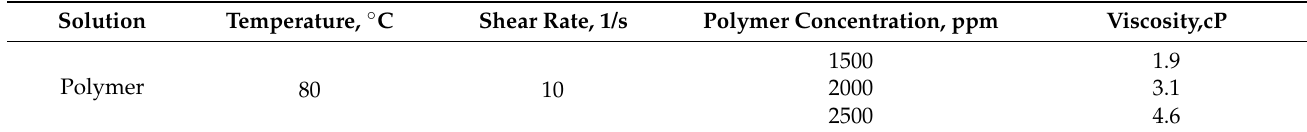
Figure 6. Rheology of polymers (1500, 2000, 2500 ppm) and nano-assisted polymer at 80 °C. Table 10. Rheology of pure polymer solutions at high